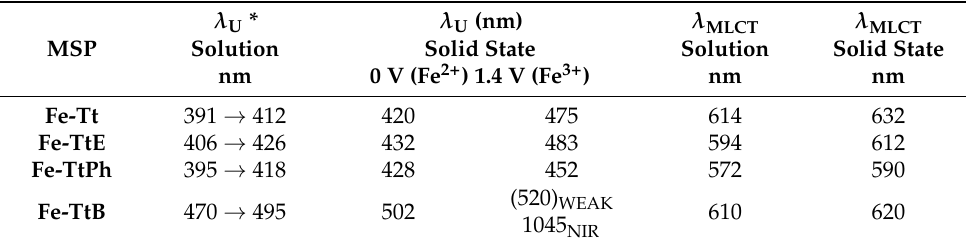
Table 1. Positions of UV/vis absorption bands of Fe-MSPs ( r = 1.0) in the solid-state and in the 1,1,1,3,3,3-Hexafluoropropan-2-ol (HFP)/acetonitrile (ACN) solution. λ U and λ MLCT are the charac- teristic wavelengths of the absorption bands of unimeric units and MLCT, respectively.